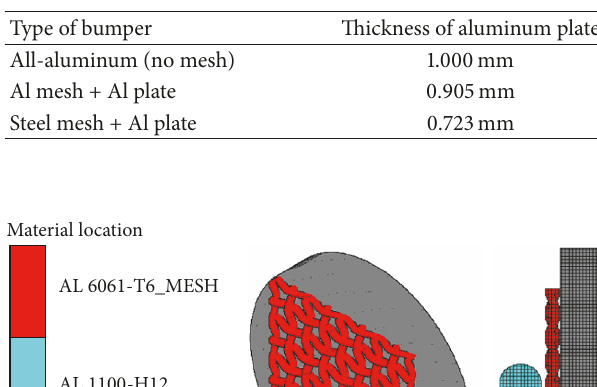
Table 1: Thicknesses of aluminum plates for different bumper configurations.